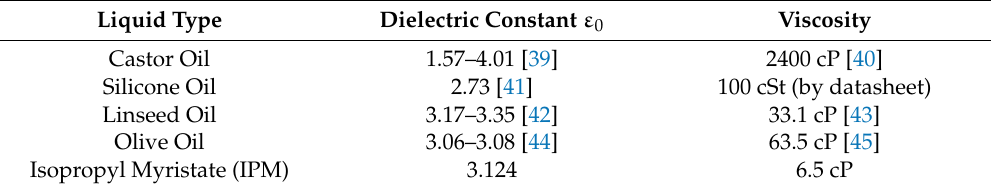
Table 2. Different types of dielectric liquid and their